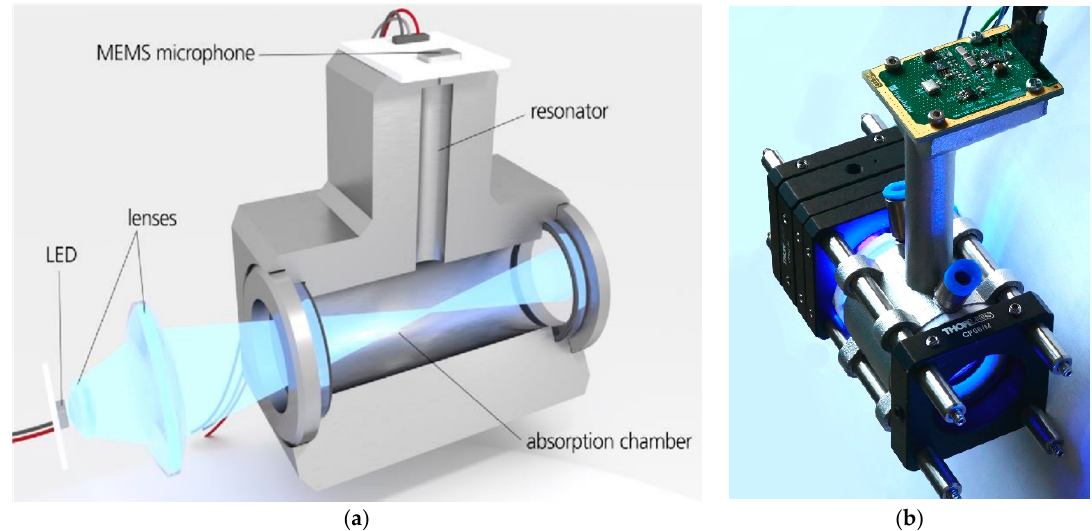
Figure 1. ( a ) CGI-rendered cross-section of a resonant photoacoustic T-shaped cell design.